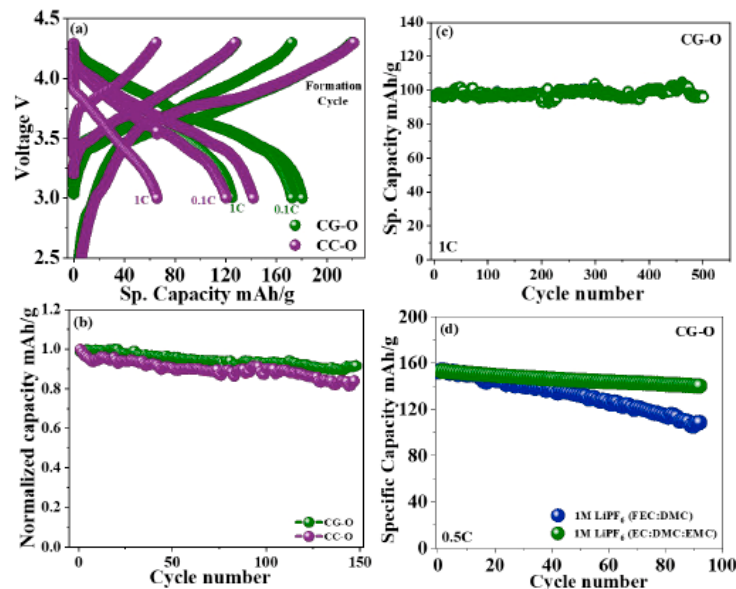
Figure 6. ( a ) Charge–discharge plateau of formation cycle, at 0.1 C rate and 1 C in full cells with CG-O cathode (see Figure 5) and graphite anode in the voltage range of 3.0–4.3V. ( b ) Normalized full cell cyclic stability 1 C rate in the voltage range of 3.0–4.3V of CC-O and CG-O. ( c ) Cyclic stability of CG-O in the voltage range of 3.0–4.2V. ( d ) Comparison of cyclic stability of CG-O with di ff erent electrolytes. Reproduced with permission from [144]. Copyright 2020 American Chemical